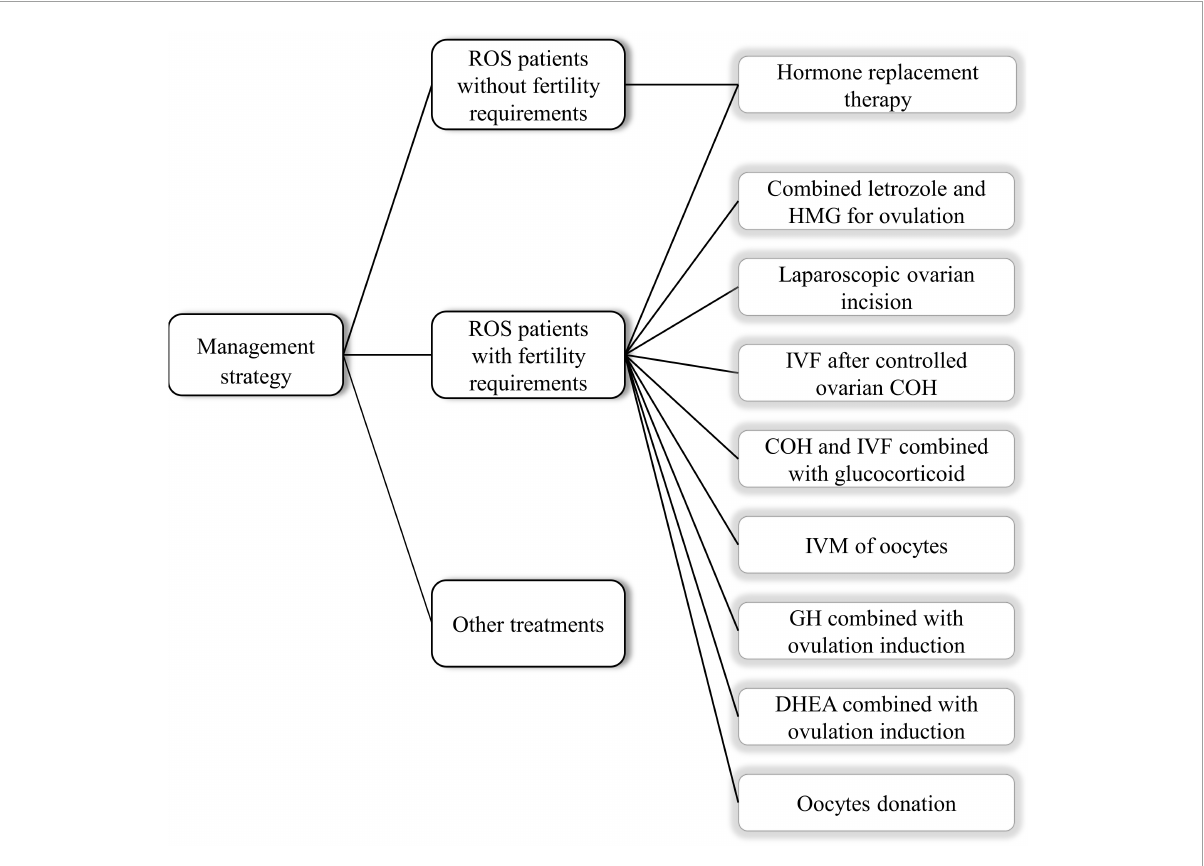
FIGURE3 The specific clinical treatments of resistant ovary syndrome (ROS)